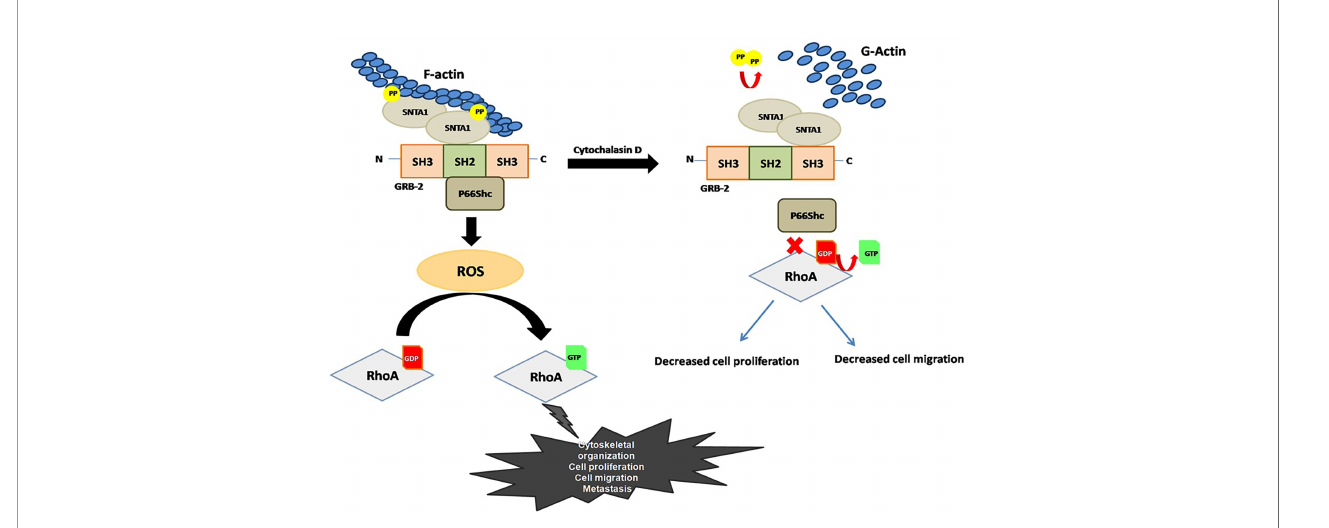
FIGURE 6 | Proposed model for the role F-actin in the regulation of SNTA1-p66Shc mediated RhoA activity in metastatic breast cancer